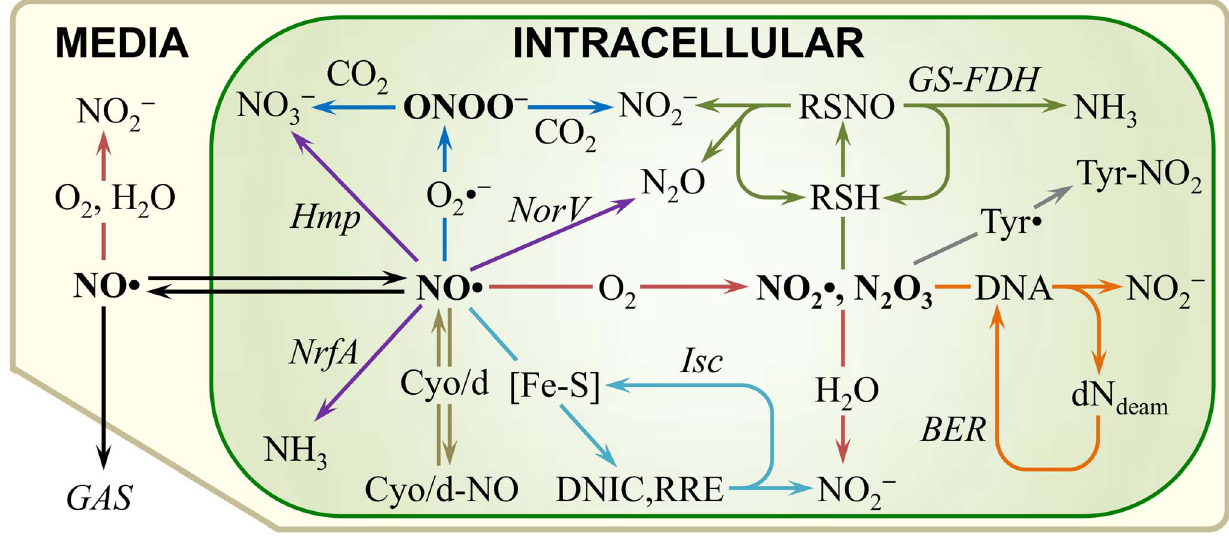
Figure 1. Simplified diagram of the NO N biochemical reaction network in an E.coli culture. The intracellular and extracellular (media) compartments are represented by the green and tan shaded regions, respectively. The lower-left corner represents the gas phase in direct contact with the liquid media. Species in bold text represent NO N and its reactive oxidized forms (NO 2 N , N 2 O 3 , and ONOO 2 ). Italic text indicates the enzyme or group of enzymes responsible for the associated reaction/pathway. Red reaction arrows represent NO N autoxidation; purple, enzymatic detoxification; blue, ONOO 2 formation and degradation; tan, cytochrome inhibition; teal, [Fe-S] nitrosylation and repair; green, thiol nitrosation and denitrosation; gray, tyrosine nitration; orange, DNA deamination and repair.